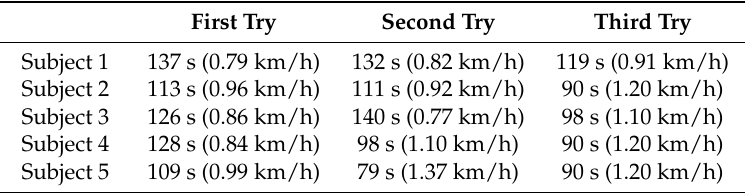
Table 6. Results of the third walking test (time and speed).